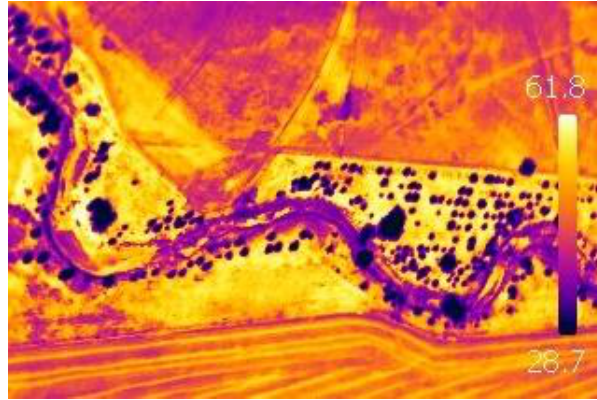
Figure 9. Image of surface temperature taken with SUSI 62 (NSW